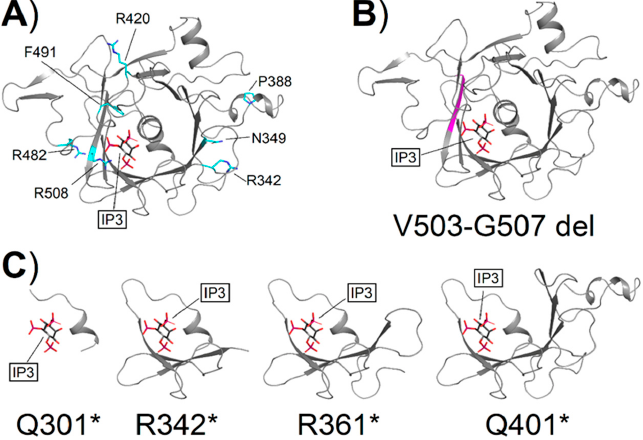
Figure 8. ( A ) Localization of TULP1 missense variants identified in this study. The three-dimensional structure of IP 3 -bound TULP1 is shown as gray cartoons. Residues whose mutations are associated with retinal degeneration in this study are labeled and represented as cyan sticks (C atoms) with O atoms in red and N atoms in blue. ( B ) The theoretical 3D structure of the IP 3 -bound TULP1 V503-G507 del variant, the region encompassing residues 503–507, is shown in magenta. ( C ) The theoretical 3D structure of IP 3 -bound TULP1 Q301* [44], R342*, R361* [45], and Q401* [15] nonsense variants. IP 3 is framed and represented as sticks with C atoms in black, P atoms in violet, and O atoms in red.